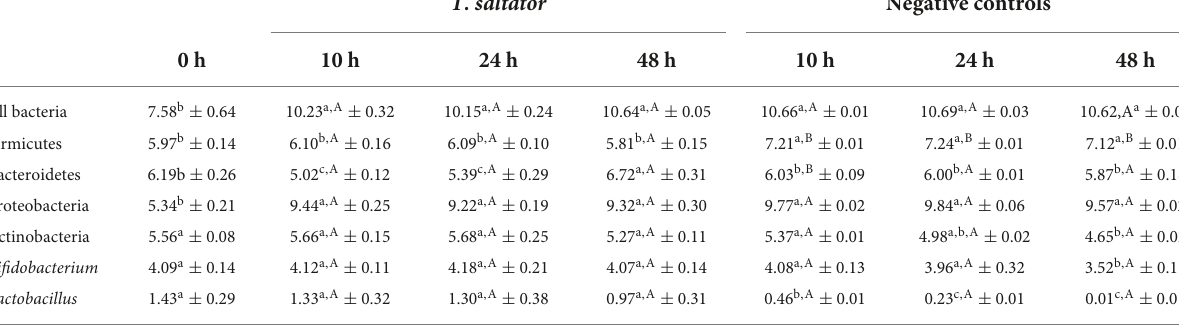
TABLE 2 Bacterial population (log 10 DNA copies/mL) in the in vitro colon model after 0, 10, 24, and 48 h of fermentation. T. saltator